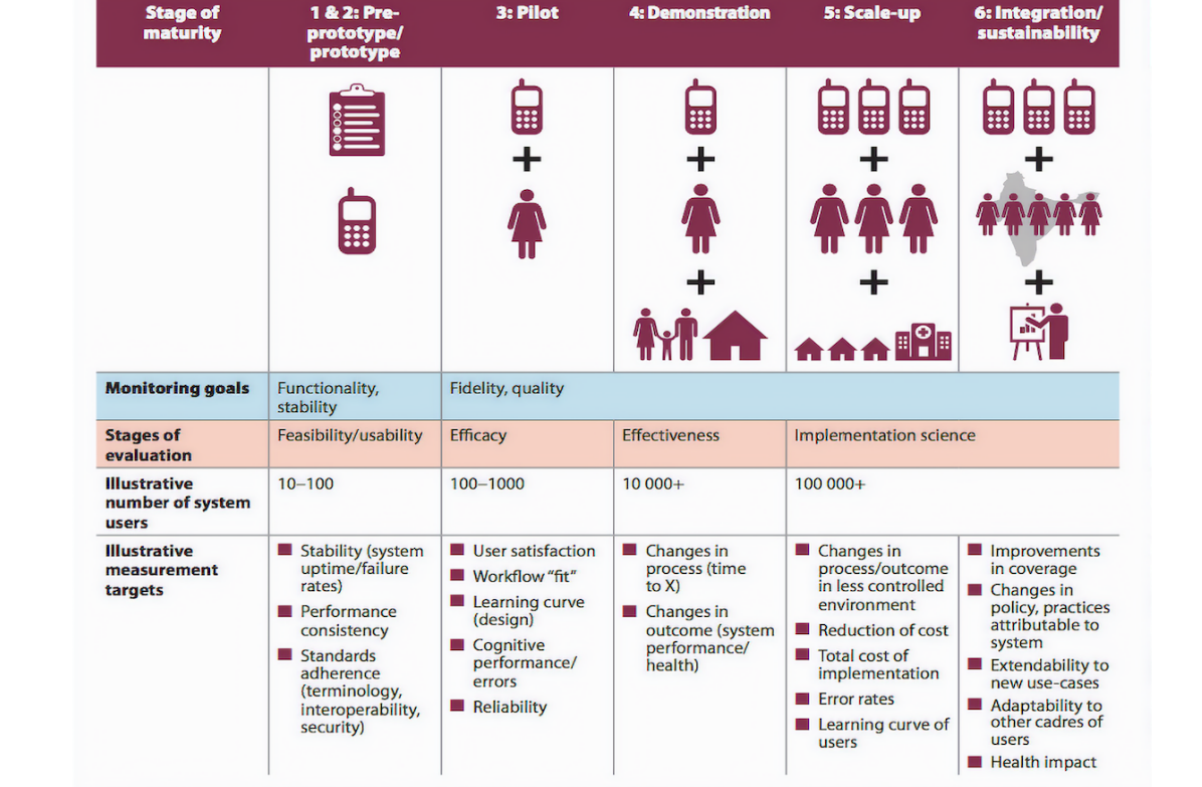
Figure 2. World Health Organization Mobile health evidence and reporting assessment schematic depiction of the six stages of the intervention maturity life-cycle, from preprototype to national level